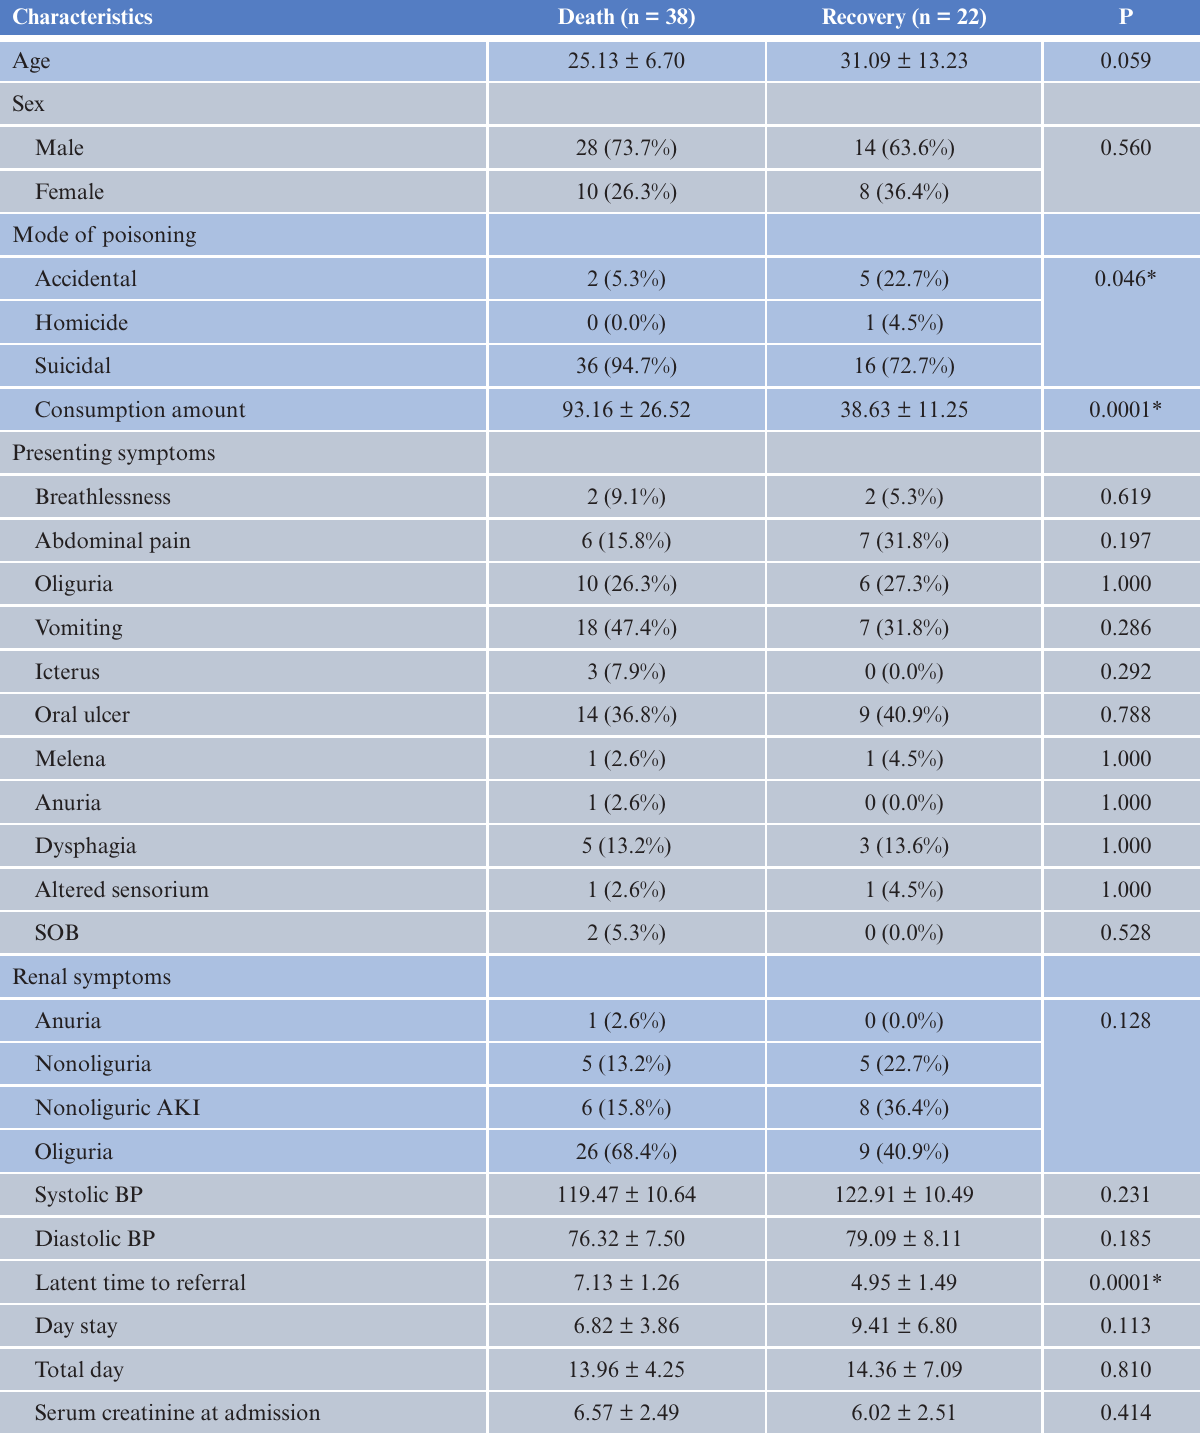
Table 3: Factors associated with